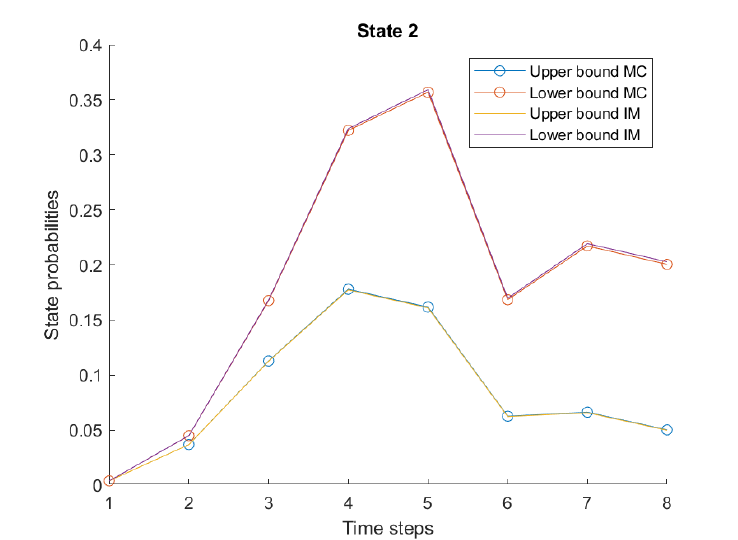
Figure 5. Monte Carlo (MC) and Interval Mathematics (IM) bounds for the probability of state 2, in case of one uncertainty source.